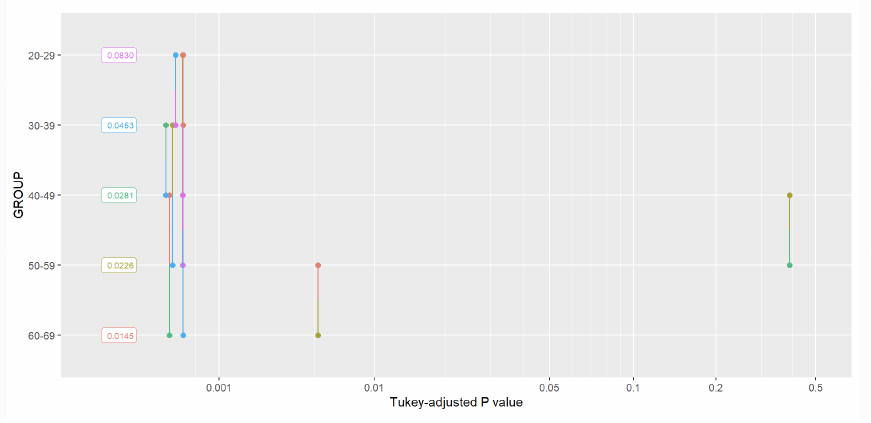
Figure 4. The RR Tukey analysis results.